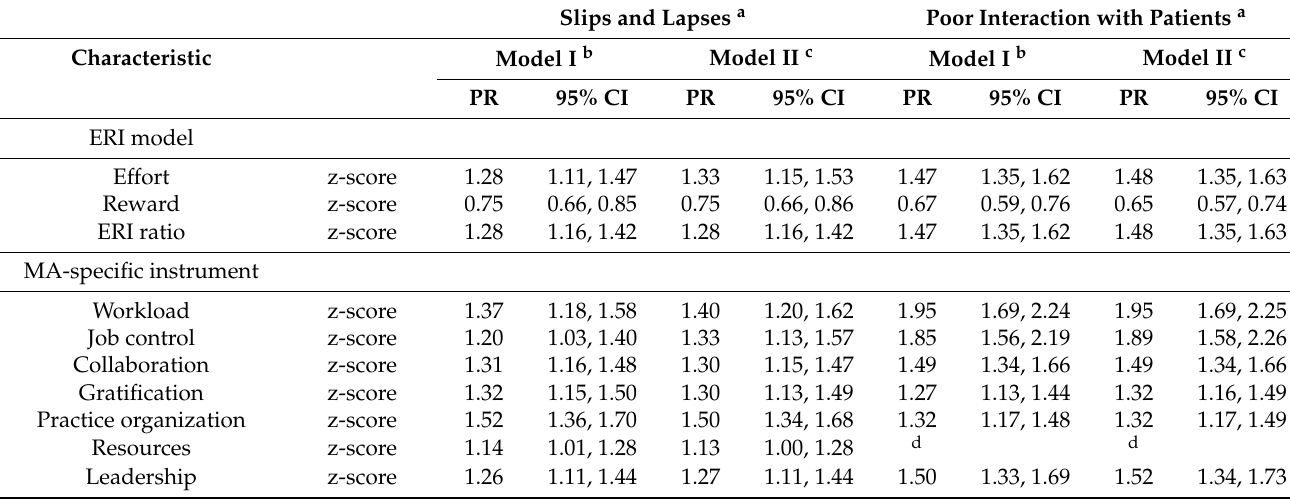
work stress-associated slips and lapses and ≥ 10 for work stress-associated poor interaction with patients; b unadjusted; c additionally adjusted for age, gender, and leadership position; d sub-scale “resources” removed from analyses for “poor interaction with patients” due to conceptual